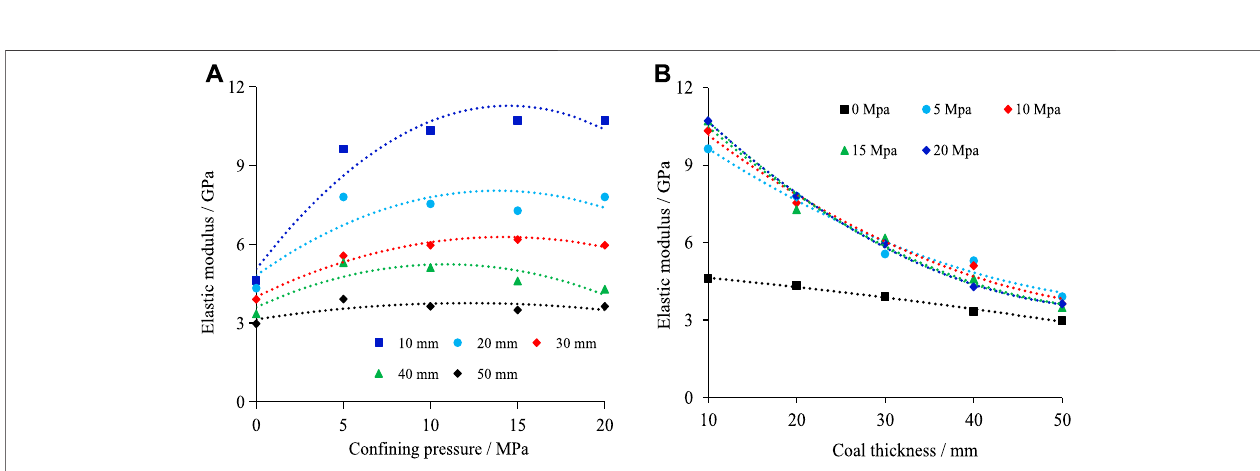
FIGURE8| ElasticModulusoftheRCRcompositesatdifferentinclinedcoalseamthicknessesanddifferentcon fi ningpressures. (A) In fl uenceofdifferentcon fi ning pressure; (B) In fl uence of different coal thickness.